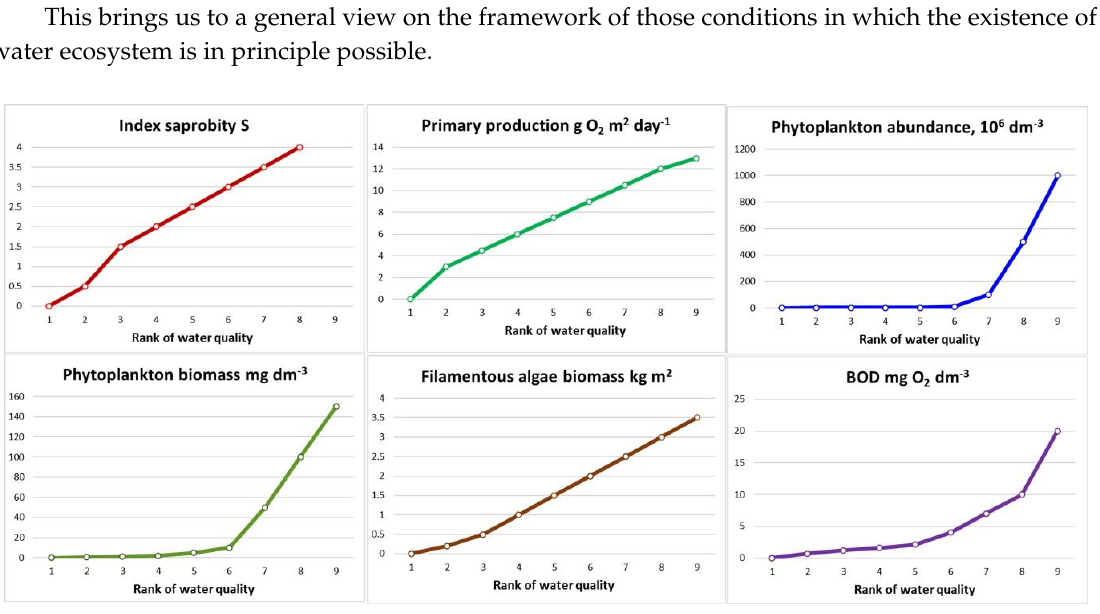
Figure 3. Distribution of some water ecosystem trophic-related variables in the gradient of increasing organic load from rank 1 to rank 9 (according to [18,33,34]).